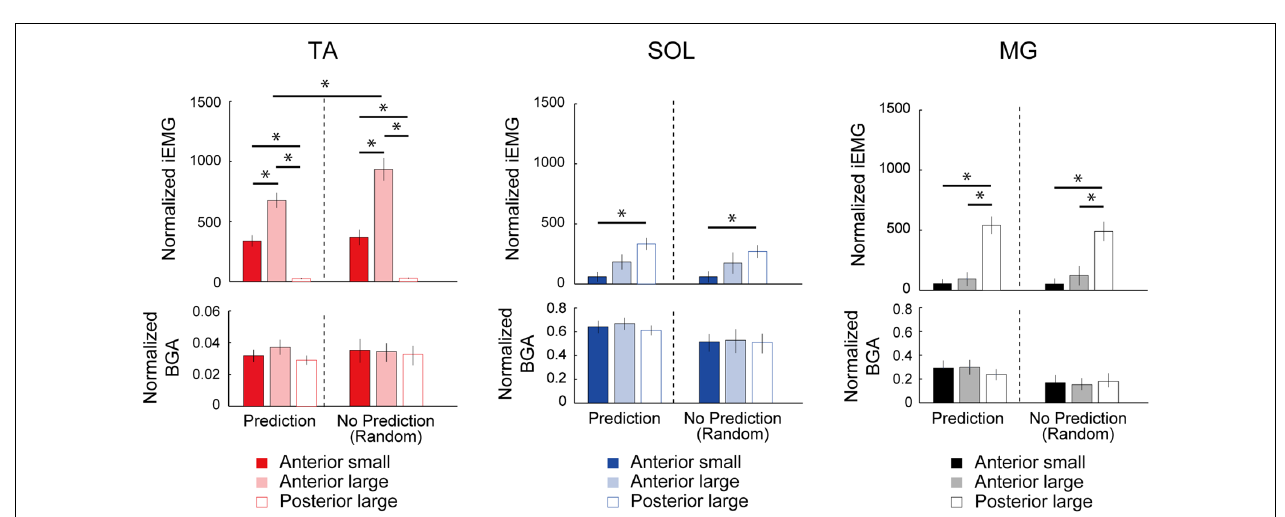
FIGURE 4 | Comparison of the normalized integral electromyographic (EMG) values for 100 ms post-EMG onset between the predictable (Low, High, Posterior) and unpredictable (Random) conditions. The TA-EMG in the Anterior-large perturbation was significantly different between the High and Random conditions. In the comparison of the three types of perturbations, there were significant differences of integrated EMG (iEMG) in all three muscles depending on the perturbation direction. The BGA activities were not significantly different among the three types of perturbation. TA, tibialis anterior; SOL, soleus; MG, medial gastrocnemius. Asterisks indicate the statistically significant differences between